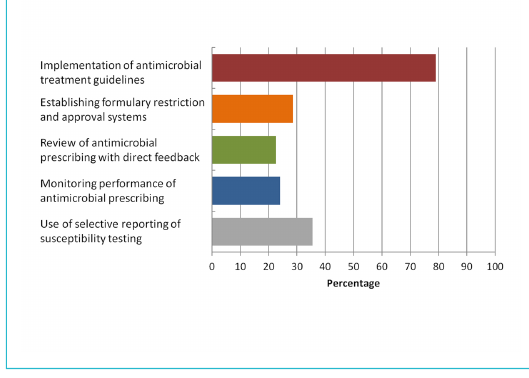
Figure 1: Presence of the five essential antimicrobial stewardship strategies (as defined by the Australian Commission on Safety and Quality in Health Care) in Swiss hospitals surveyed (n =